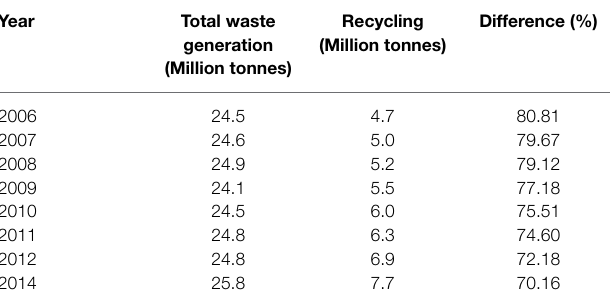
TABLE 1 | Difference between total plastic waste and recycled